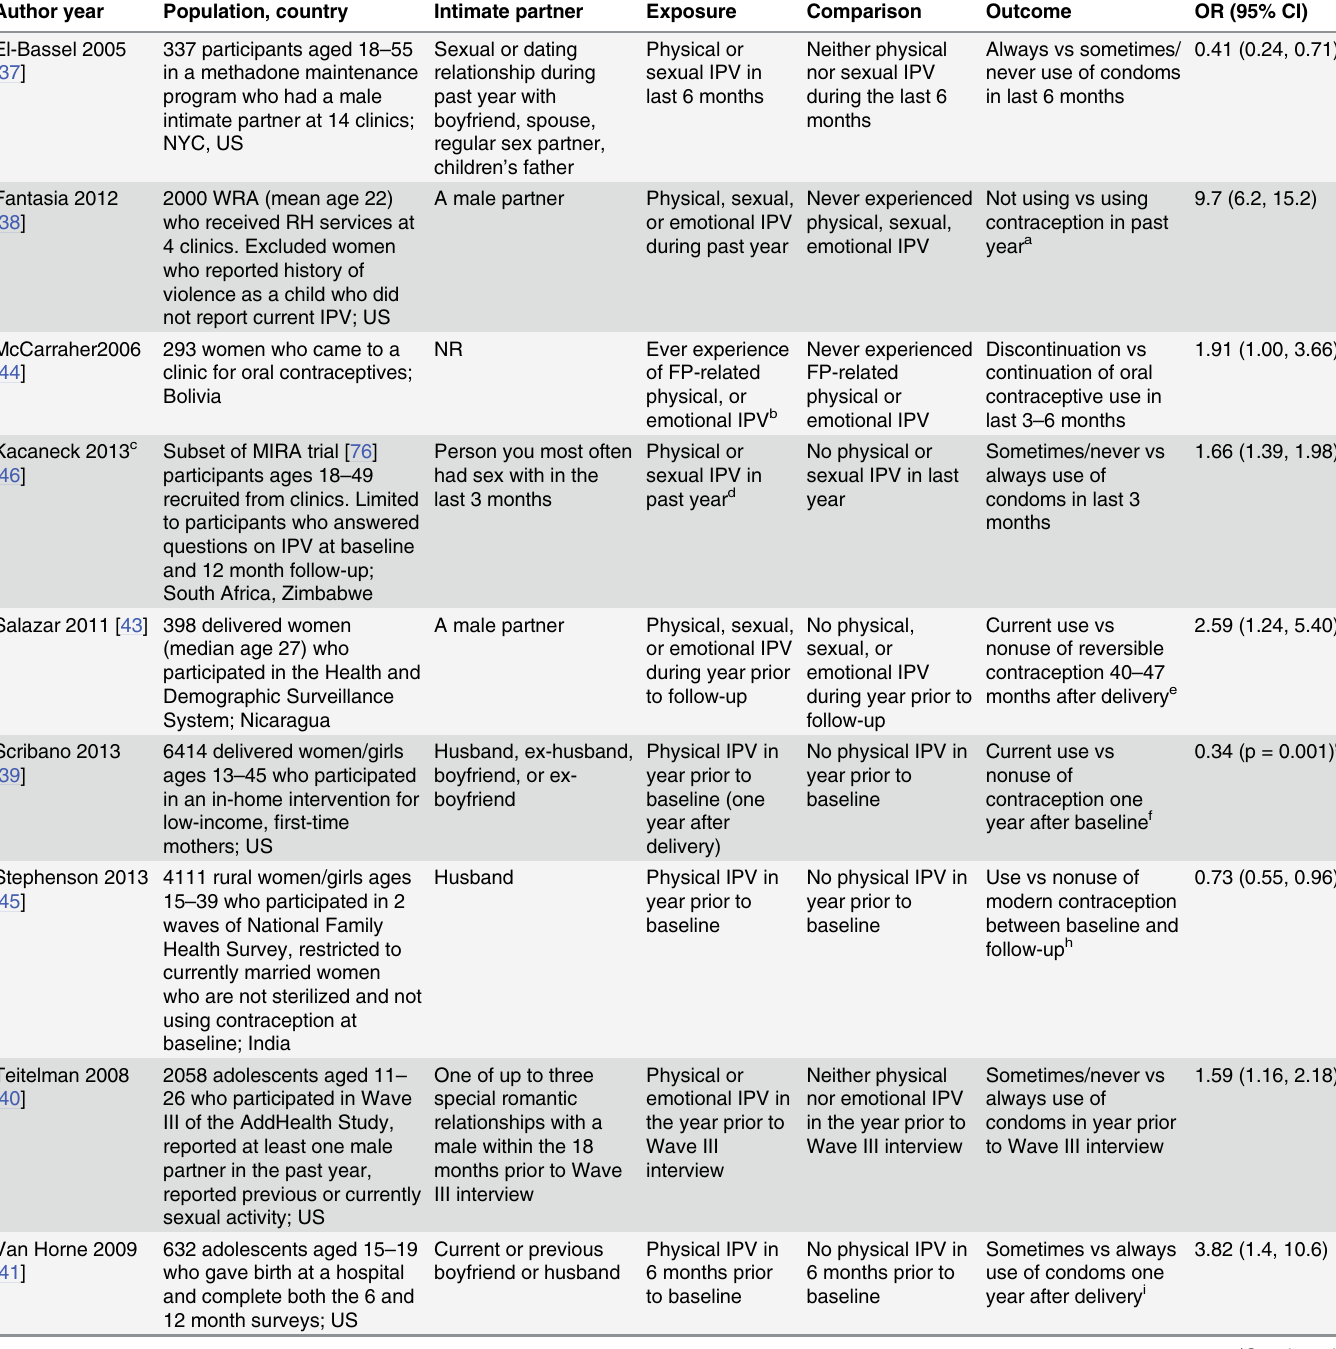
Table 1. Summary of longitudinal, RCT, and case-control studies that examine the association between IPV and women ’ s contraceptive use. Author